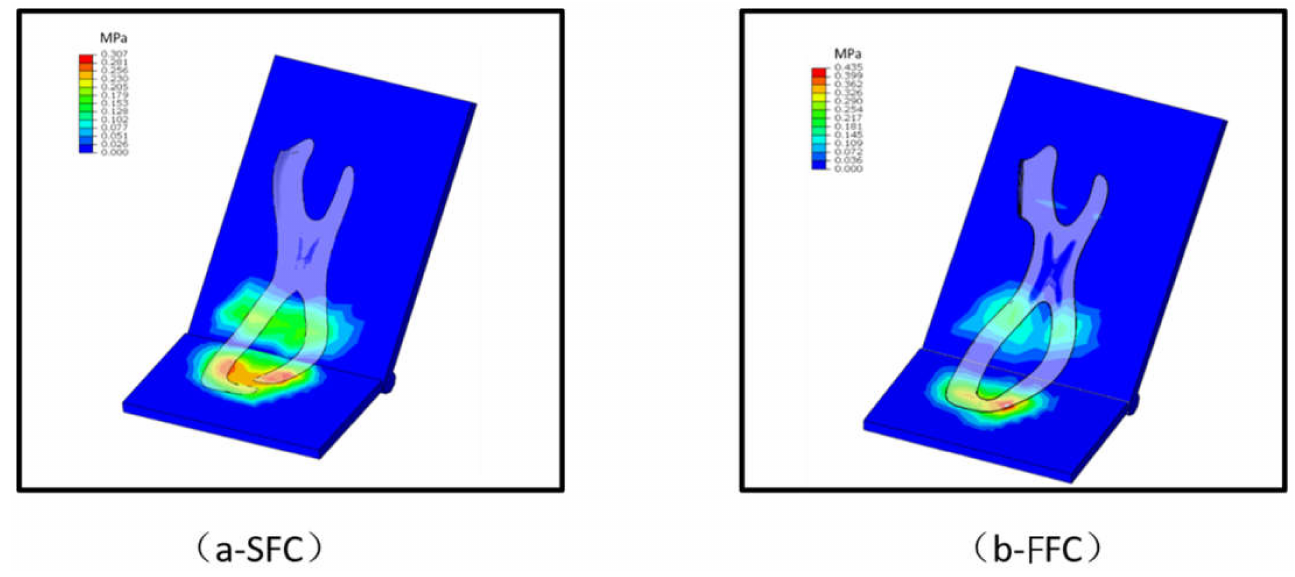
Figure 3. The pressure on the SFC and FFC during bending. Table 1. The forefoot flexion scores for experimental shoes with the same insole and the FE simulation variables for experimental carbon fiber